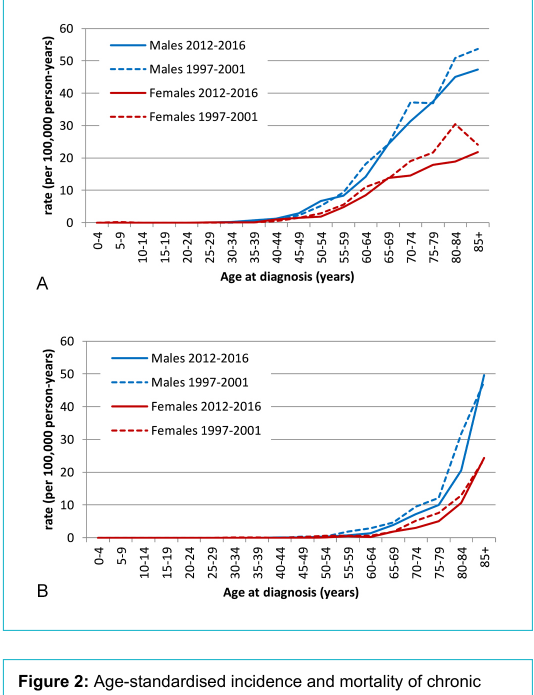
Figure 2: Age-standardised incidence and mortality of chronic lymphocytic leukaemia / small lymphocytic lymphoma by sex and time period(a) Incidence(b)